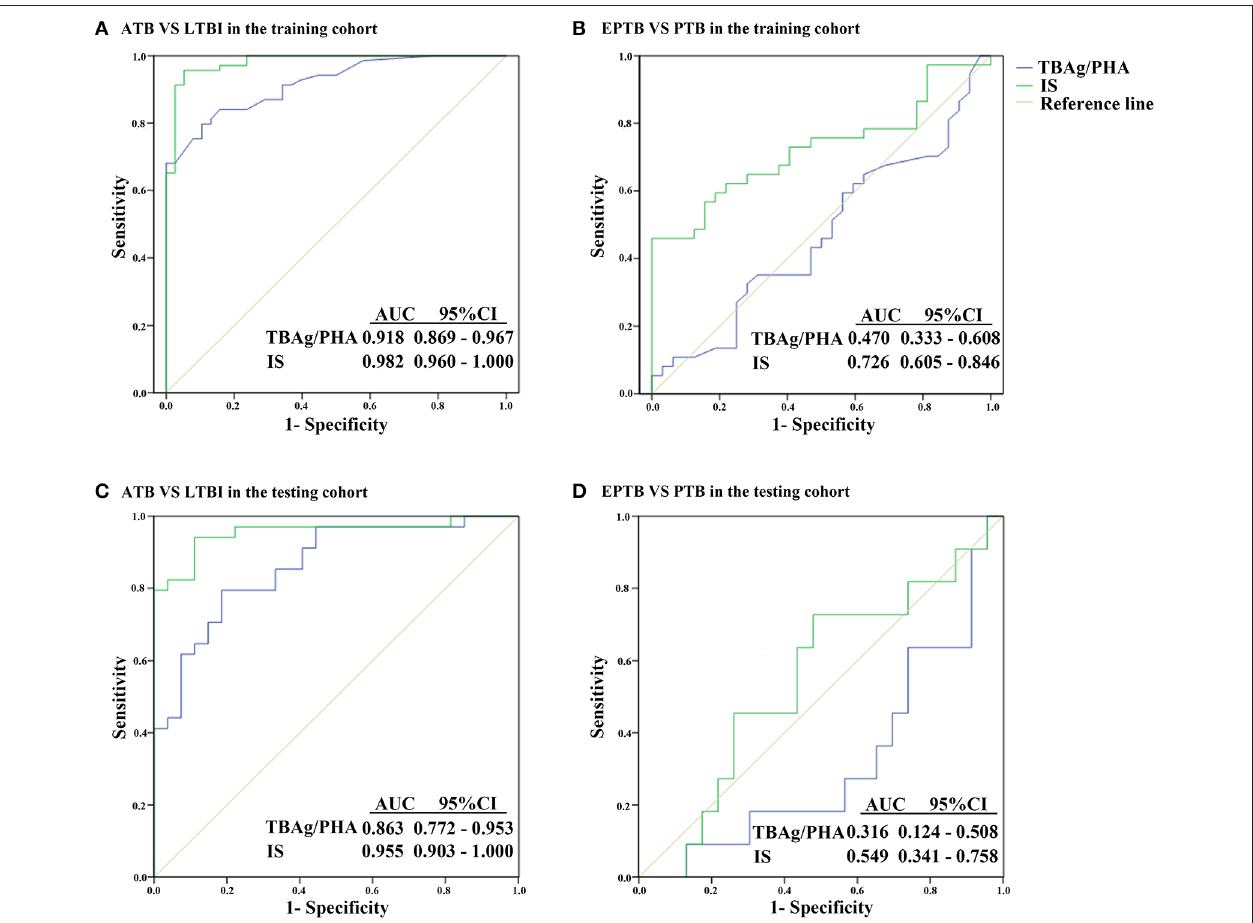
FIGURE 3 | ROC analysis of the TBAg/PHA ratio and IS model for distinguishing different TB disease states. (A) ROC analysis of the TBAg/PHA ratio and IS for ATB and LTBI discrimination in the training cohort. (B) ROC analysis of the TBAg/PHA ratio and IS for EPTB and PTB discrimination in the training cohort. (C) ROC analysis of the TBAg/PHA ratio and IS for ATB and LTBI discrimination in the testing cohort. (D) ROC analysis of the TBAg/PHA ratio and IS for EPTB and PTB discrimination in the testing cohort. ATB, active tuberculosis; LTBI, latent tuberculosis infection; EPTB, extrapulmonary tuberculosis; PTB, pulmonary tuberculosis; AUC, area under the